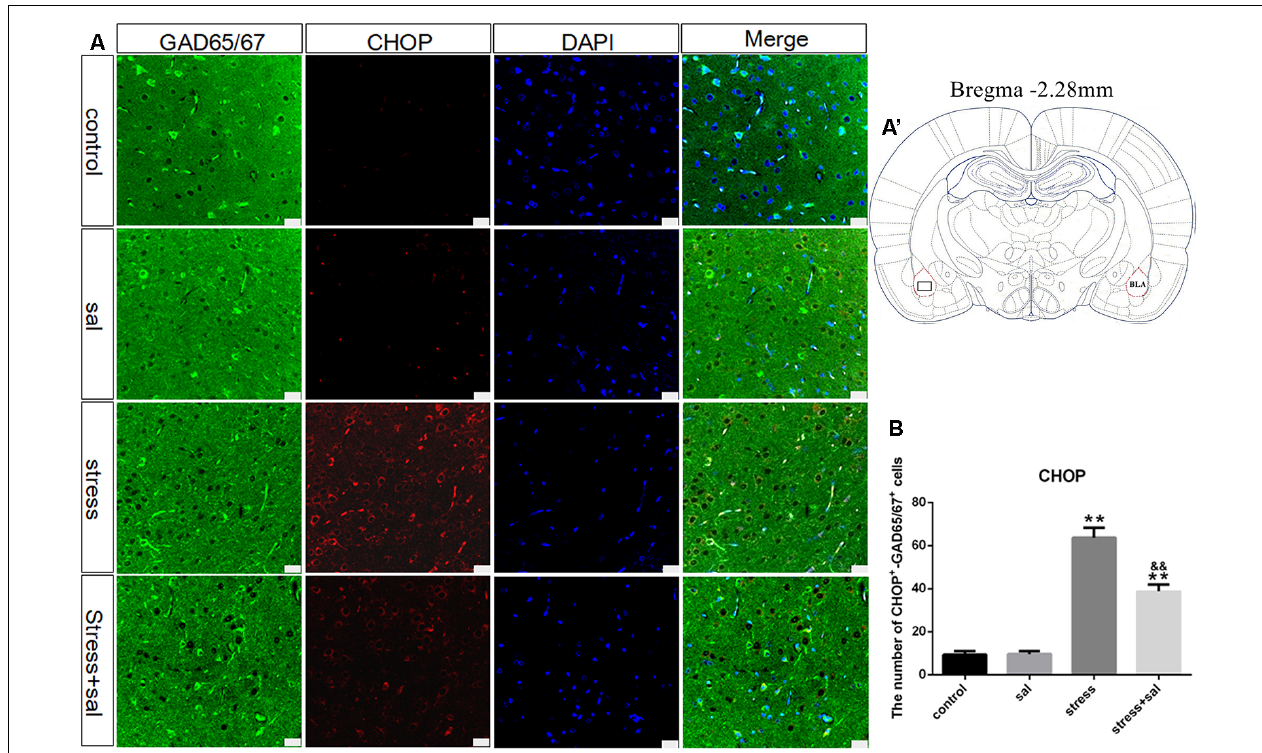
FIGURE 8 | Number of GAD65/67 positive neurons expressing CHOP in the BLA. (A) Representative confocal images showing coronal sections of rat immunostained for GAD65/67 (green), CHOP (red), DAPI (nuclear stain, blue) and merged (orange/yellow). Bars = 25 µ m. The analyzed region within the BLA is schematically illustrated in (A (cid:48) ) (diagram modified from Paxinos and Watson, 2007). (B) Quantitative analysis of the number of CHOP + -GAD65/67 + cells (one-way ANOVA). Data are shown as mean ± SEM, ∗∗ P < 0.01 vs. control group, && P < 0.01 vs. stress group ( n =